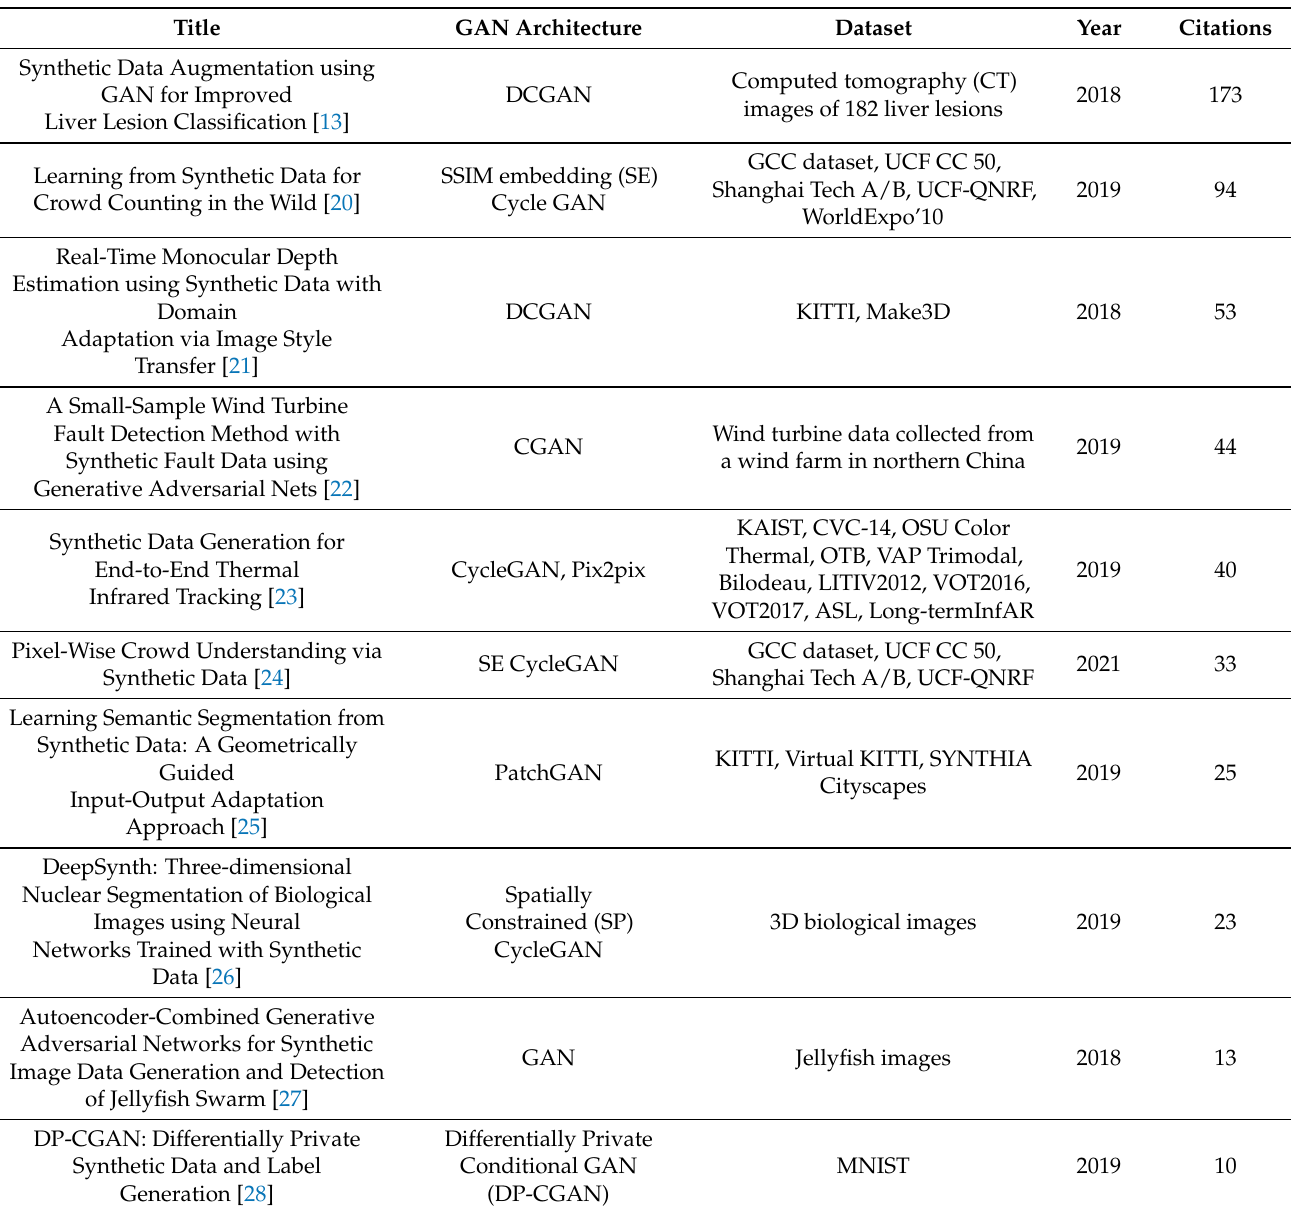
Table 3. Top 10 cited papers in the Web of Sciences database that use